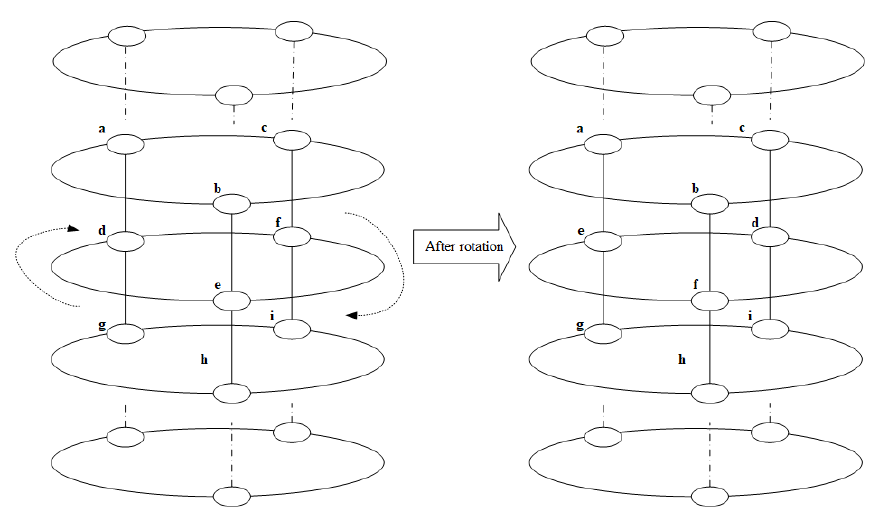
Figure 9. Multi-Ring topology.